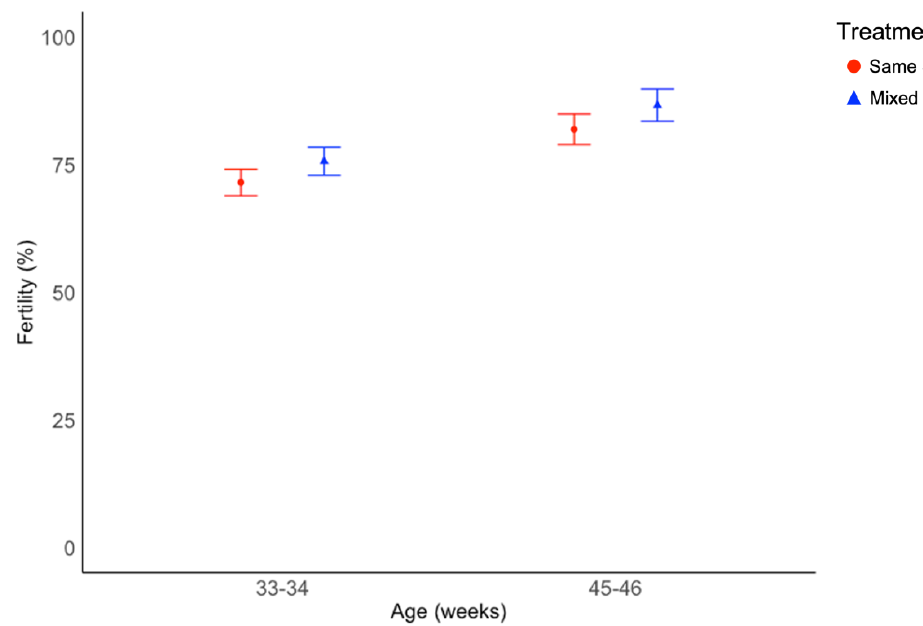
Figure 5. Average fertility percentages calculated based on pen-level data collected when ducks were 33 and 34, and 45 and 46 week of age. Average flock fertility differed by age ( p < 0.001), but not treatment. Fertility values are back-transformed from a logarithmic transformation and presented as estimated marginal means and standard errors. Fertility was determined based on candling of